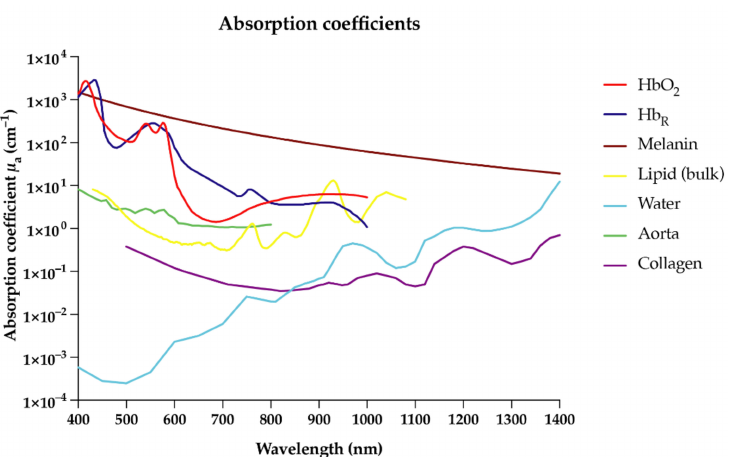
Figure 1. Absorption coefficients ( µ a in cm − 1 ) versus wavelength (in nm) for different optoa- coustic imaging molecules and tissue. Spectra were derived from existing data as indicated: melanin (https://omlc.org/spectra/melanin/mua.html as derived from [15–18]), oxy- (HbO 2 ) and deoxyhemoglobin (Hb R ) (https://omlc.org/spectra/hemoglobin/summary.html), (bulk) lipid (https://omlc.org/spectra/fat/fat.txt as derived from [19]), water (https://omlc.org/spectra/water/ data/hale73.txt derived from [20]), aorta tissue (https://omlc.org/spectra/aorta/oraevsky_a.txt derived from [21]), and collagen (extracted from [22]). All databases accessed on 9 April